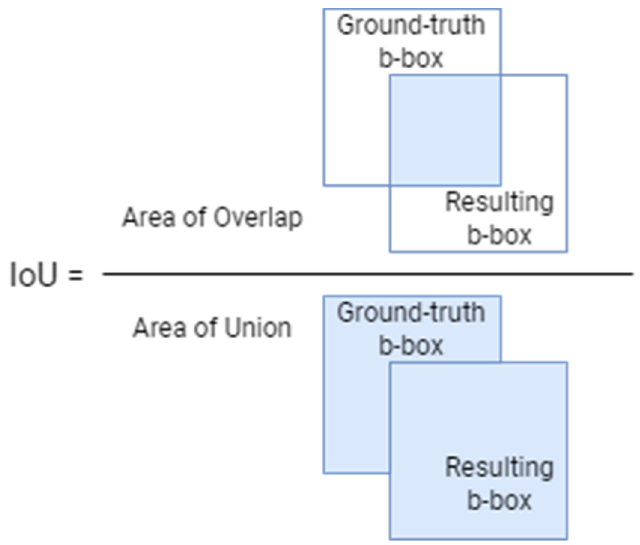
Figure 12. Intersection over Union .